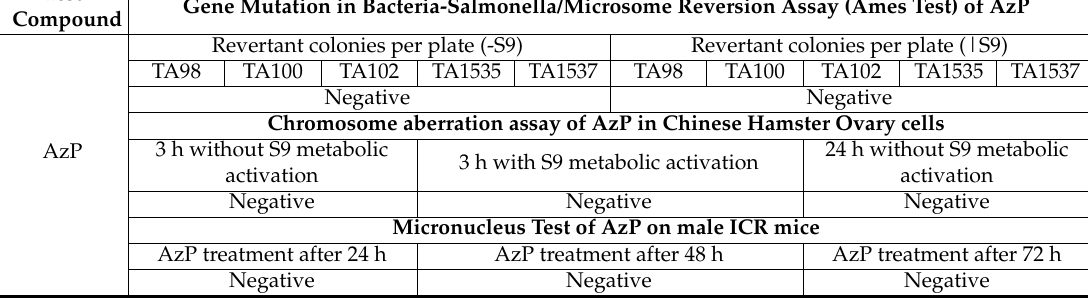
Table 2. Genotoxicity evaluation of